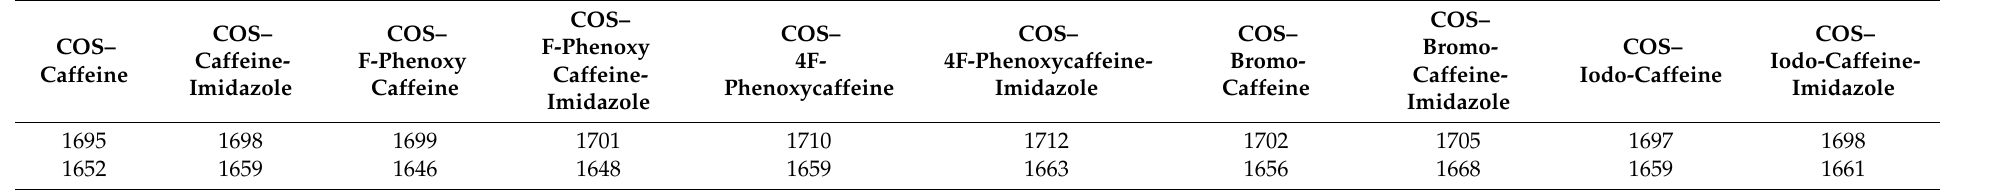
Table 2. Absorption bands in the 1700–1650 cm − 1 wavenumber range for the conjugates of caffeine derivatives (fluorophenoxy-caffeine, tetrafluorophenoxy-caffeine,